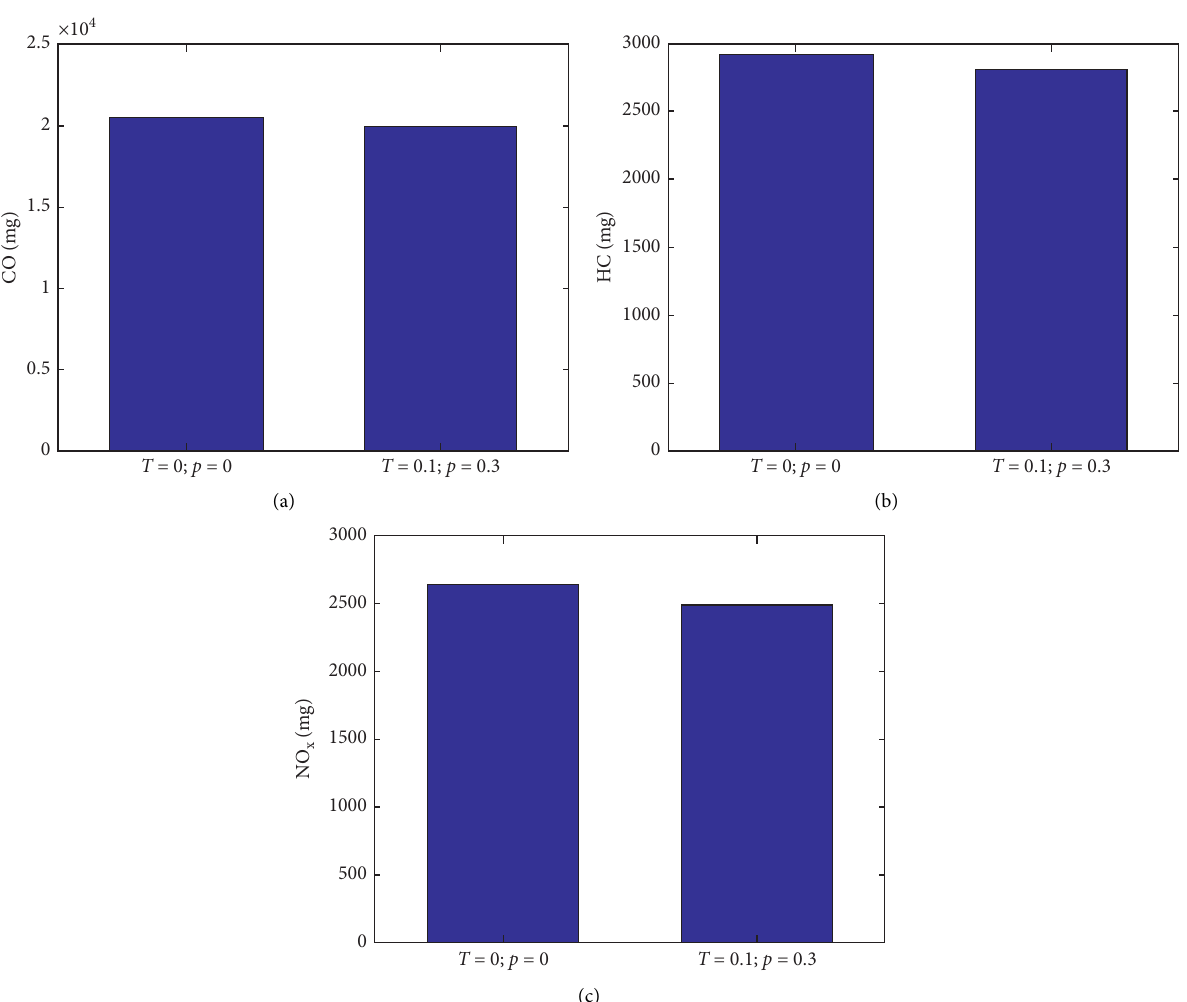
� 0, p � 0) and the AAFVD